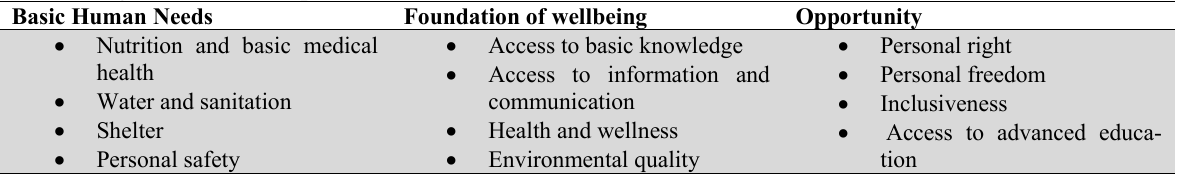
Social Progress Index component-level